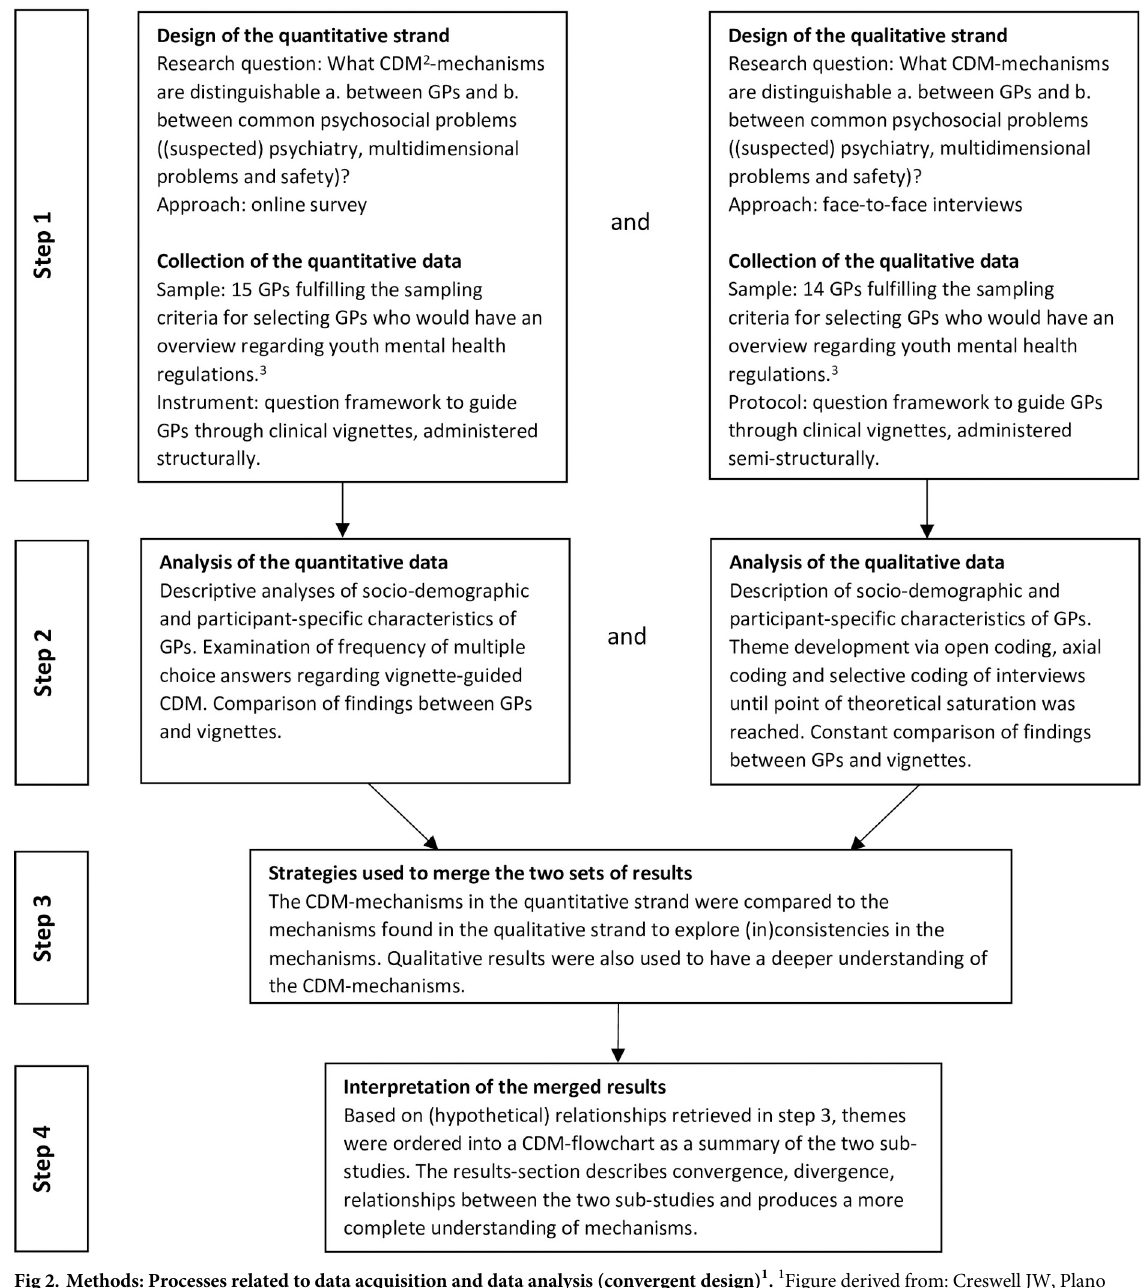
Fig 2. Methods: Processes related to data acquisition and data analysis (convergent design) 1 . 1 Figure derived from: Creswell JW, Plano Clark VL. Choosing a mixed methods design. In: Creswell JW, Plano Clark VL, editors. Designing and conducting mixed methods research. Thousand Oaks: SAGE Publications Ltd; 2017. p. 53–106. 2 CDM = Clinical Decision-Making. 3 Sampling criteria included district in which GPs’ general practices were established (with a maximum of one GP per district for the interview sub-study), GPs who reported seeing psychosocial problems among children and youth a minimum of three times per two weeks and experienced GPs who worked for